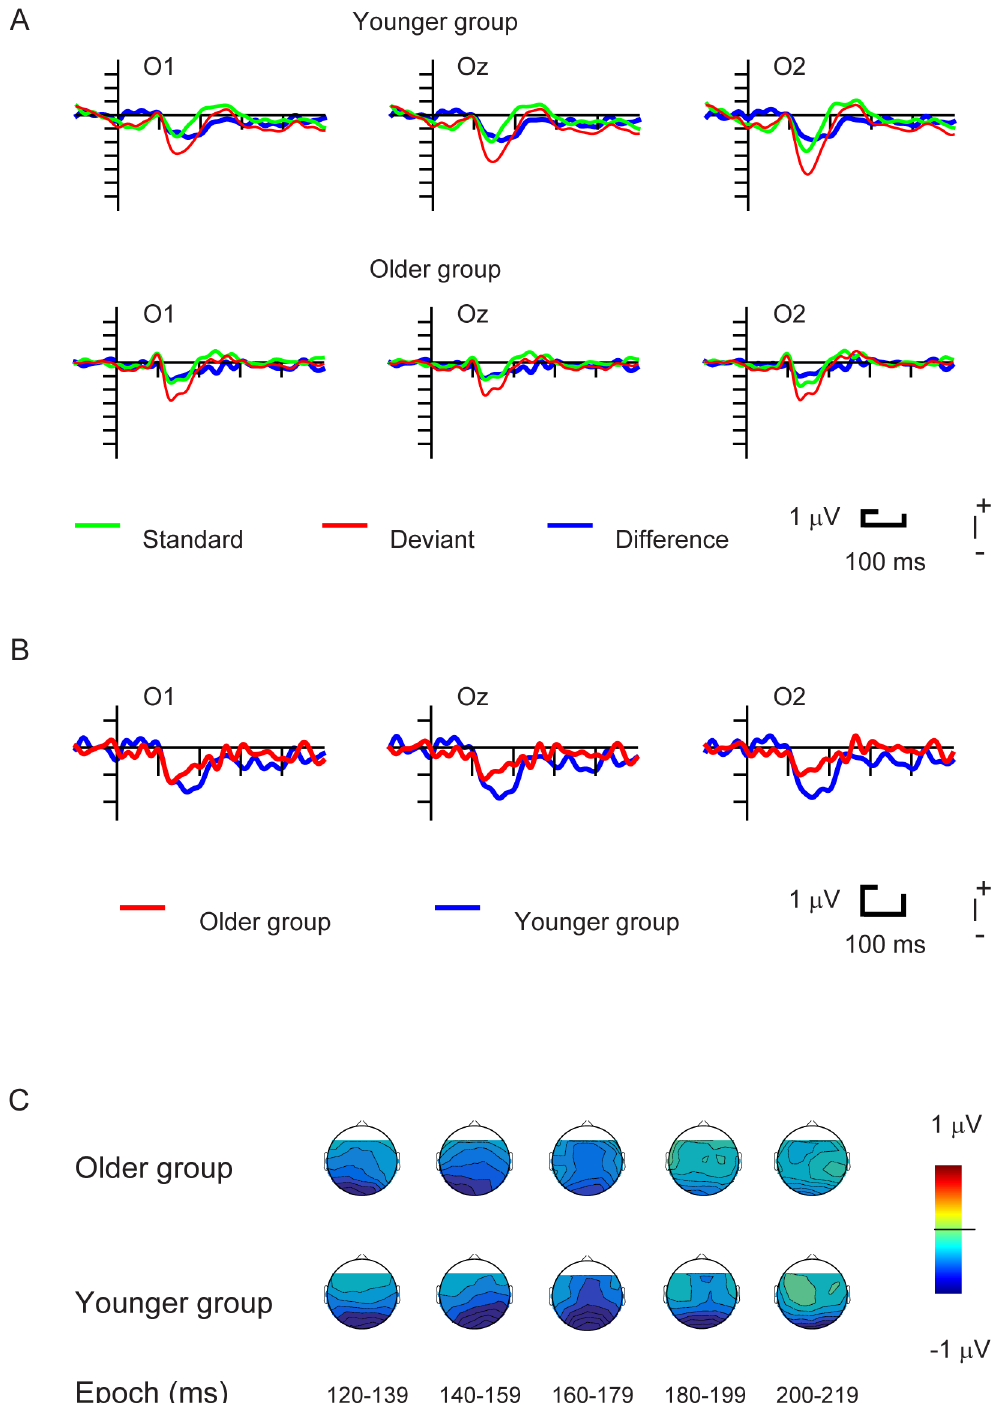
Fig 2. A. ERPs to StandardVanish, Deviant Vanish and the Deviant minus Standarddifference potentialsin Youngerand Older Group. B: Differencepotentialsin the two age groups. C: Surface distributionsof the two age groups in the 120–219ms latency